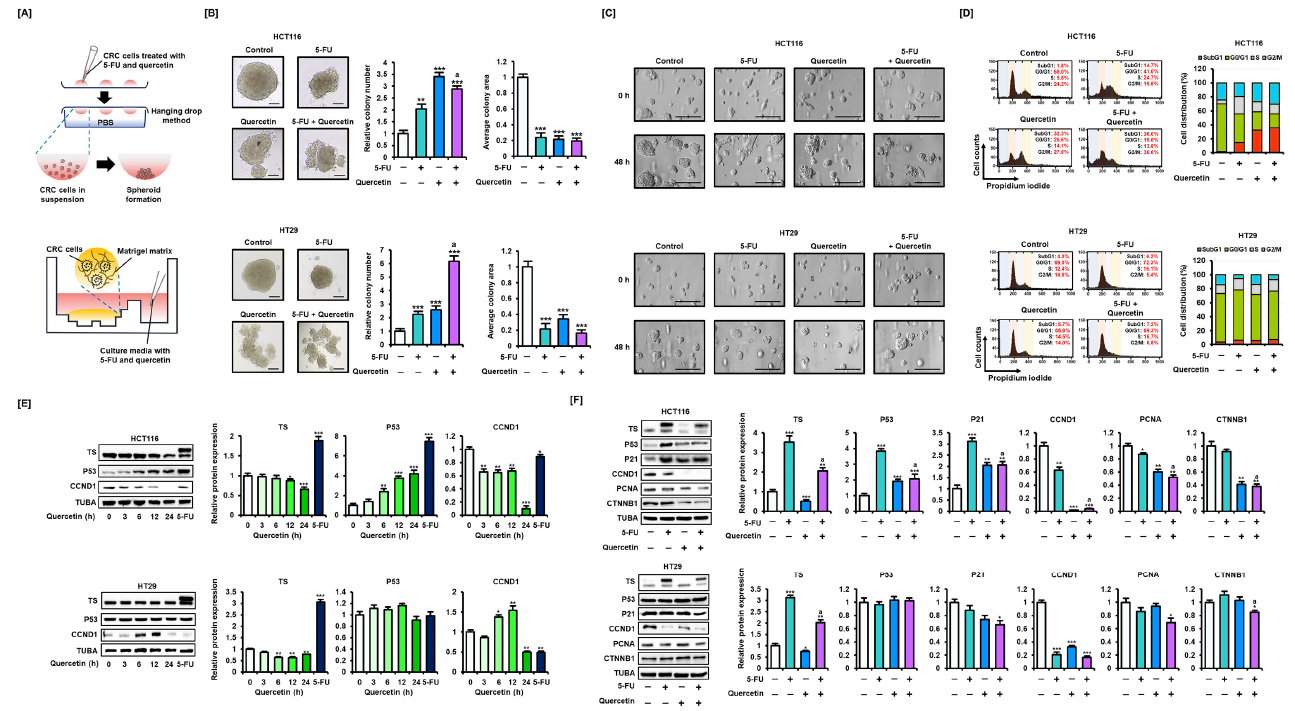
Figure 2. Effects of quercetin on alleviating the expression of target proteins in CRC cells. ( A ) A schematic diagram of spheroid formation through hanging drop method (top) and 3D tumor envi- ronment establishment in Matrigel following treatment on satellite wells (bottom). ( B ) Microscopic observation of tumor growth inhibition in spherical cancer cell colonies following the combined treatment of 5-FU (20 µ M) and quercetin (40 µ M) for 48 h. Scale bar represents 100 µ m. ImageJ software was used for a relative comparison of colony number and area. ( C ) Effects of 5-FU (20 µ M) and quercetin (40 µ M) in satellite wells on cancer cells growing in Matrigel in main wells. Scale bar represents 100 µ m. ( D ) Cell cycle distribution following combined treatment of 5-FU (20 µ M) and quercetin (40 µ M), determined by PI staining and expressed as the proportions of cells in sub-G1, G1, S, and G2/M phases over 48 h. ( E ) Expression levels of TS, p53, and CCND1 in HCT116 and HT29 cells following time-dependent treatment of quercetin (0, 3, 6, 12, and 24 h) at a concentration of 40 µ M, as analyzed by Western blot. Protein expression levels following 5-FU (20 µ M) treatment alone are also presented. ( F ) Expression of TS, p53, P21, CCND1, PCNA, and CTNNB1 in HCT116 and HT29 cells following combined treatment of 5-FU (20 µ M) and quercetin (40 µ M), as analyzed by Western blot over 24 h. Expression of TUBA was used to normalize the data. Data are presented as representatives of the results of three independent experiments. Asterisk indicates a statistically significant difference compared with untreated control cells (*** p < 0.001; ** p < 0.01; * p < 0.05). The symbol ‘a’ indicates a significant effect of combination treatment compared with the treatment with 5-FU alone ( p <